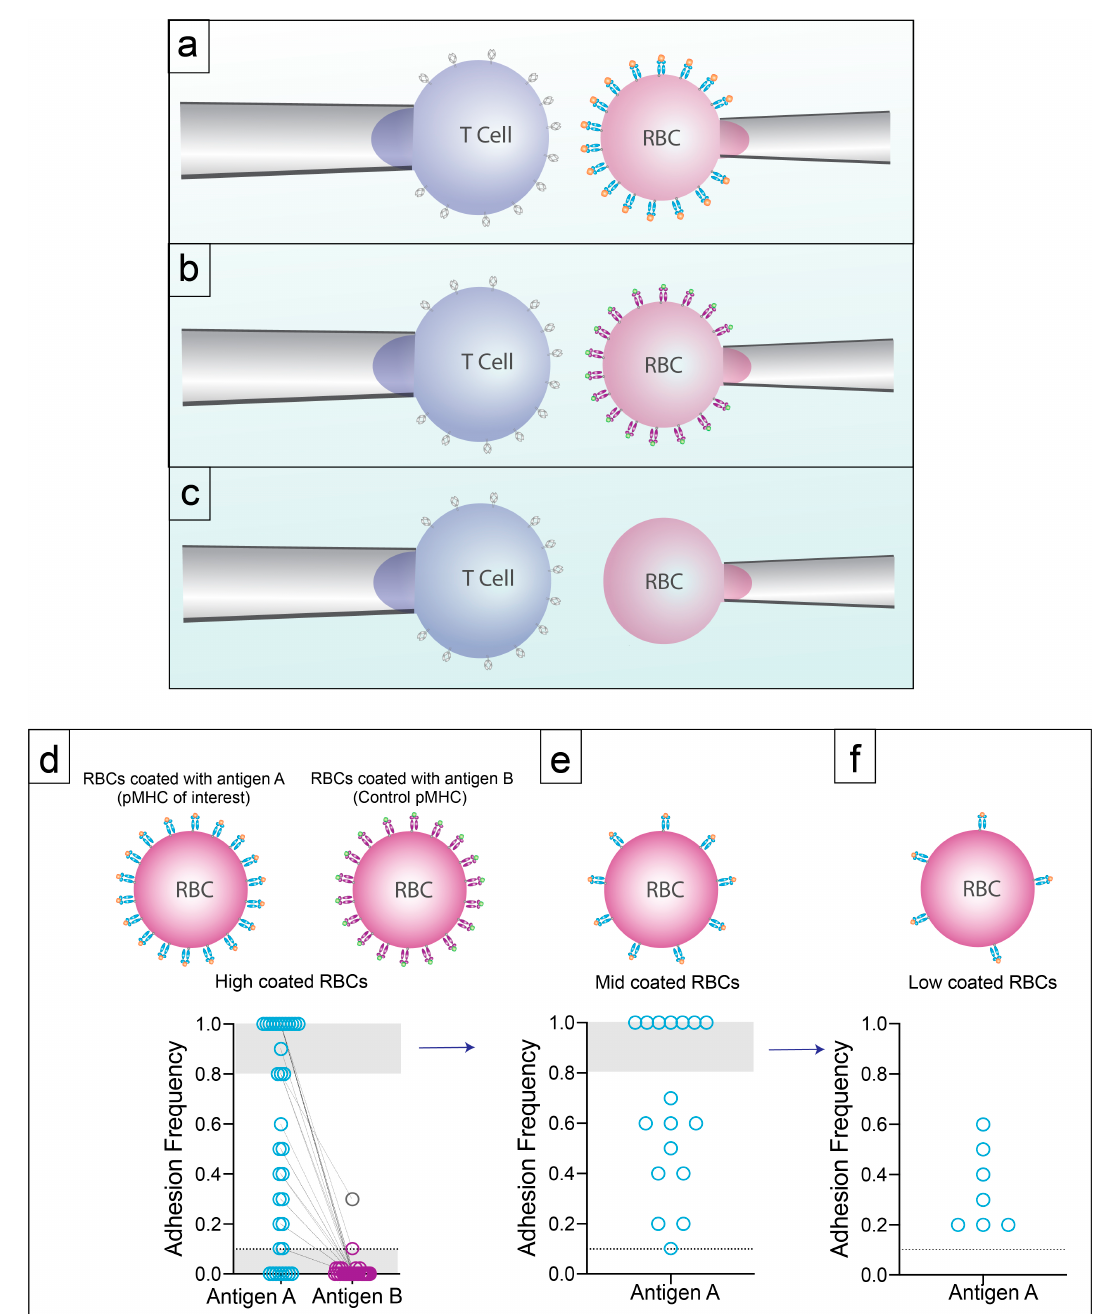
Figure 2. Controls and Specificity. ( a ) T cells of interested are aspirated onto a pipette with high density pMHC-coated hRBCs aspirated onto an opposing pipette. Cells are brought into contact using a piezoelectric actuator 50 times. ( b ) If binding is detected with pMHC of interest between the range of 10% and 80% the hRBC is switched out for a hRBC coated with an irrelevant pMHC to test specificity. ( c ) T cells tested to hRBCs without pMHC to test for non-specific binding between the T cell and non pMHC molecules on the hRBC. ( d ) Adhesion frequency of each cell tested to pMHC of interest and irrelevant pMHC. ( e ) If the pMHC of interest has an adhesion frequency of > 80% the hRBC is replaced with a hRBC coated with a lower pMHC density. ( f ) If using a lower pMHC density still yields an adhesion frequency of > 80% we continue to move to a lower pMHC density. Following this, 2D a ffi nity can be